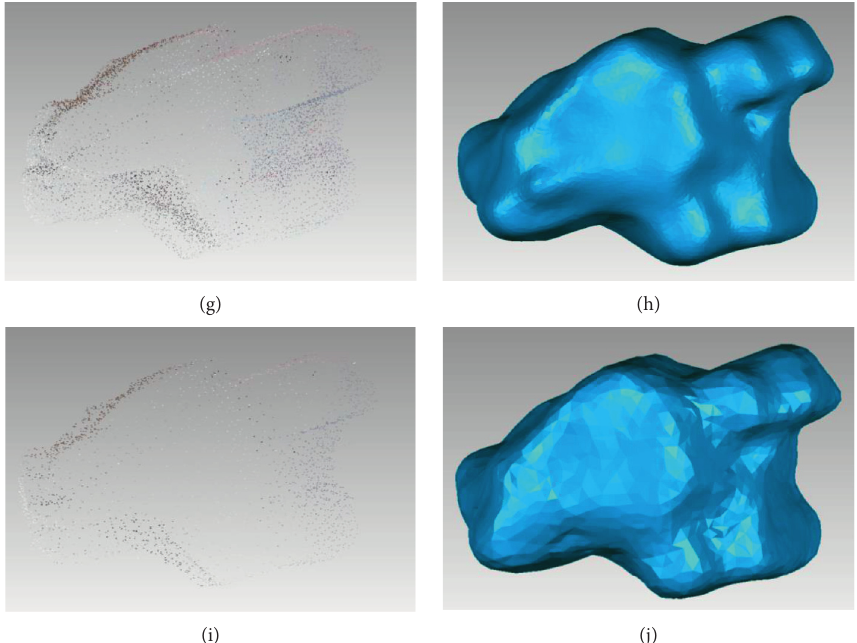
Figure 7: Points sampling and encapsulation modelling using different spacing. (a) Sampling with 0.5 times D ; (b) encapsulation model with 0.5 times D ; (c) sampling with D ; (d) encapsulation model with D ; (e) sampling with 2 times D ; (f) encapsulation model with 2 times D ; (g) sampling with 5 times D ; (h) encapsulation model with 5 times D ; (i) sampling with 10 times D ; and (j) encapsulation model with 10 times D